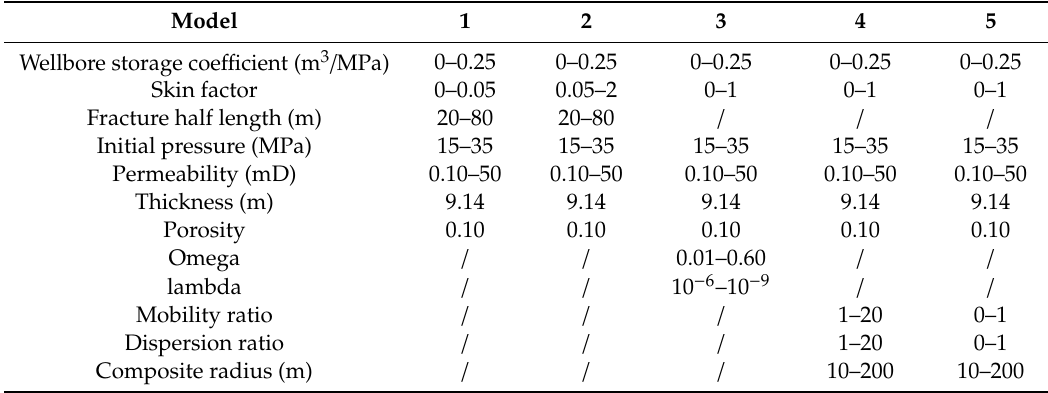
Table 1. The range of model parameters of various well test models in this paper. Model Wellbore storage coe ffi cient (m 3 /